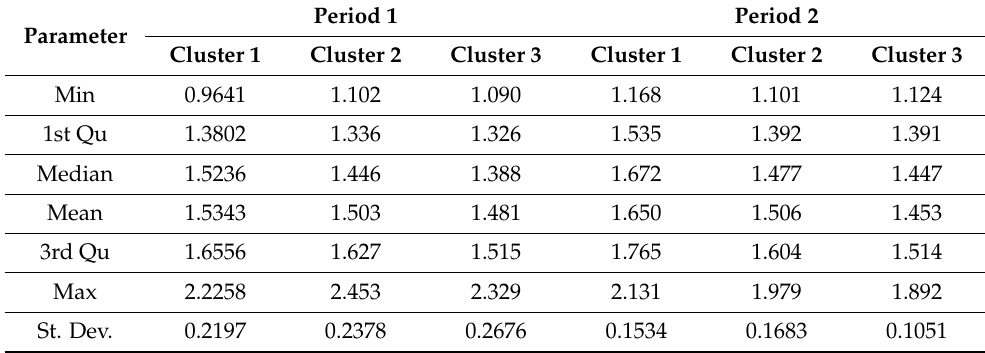
Table 18. Descriptive statistics of the THDu in phase L1 at the tested measuring point.